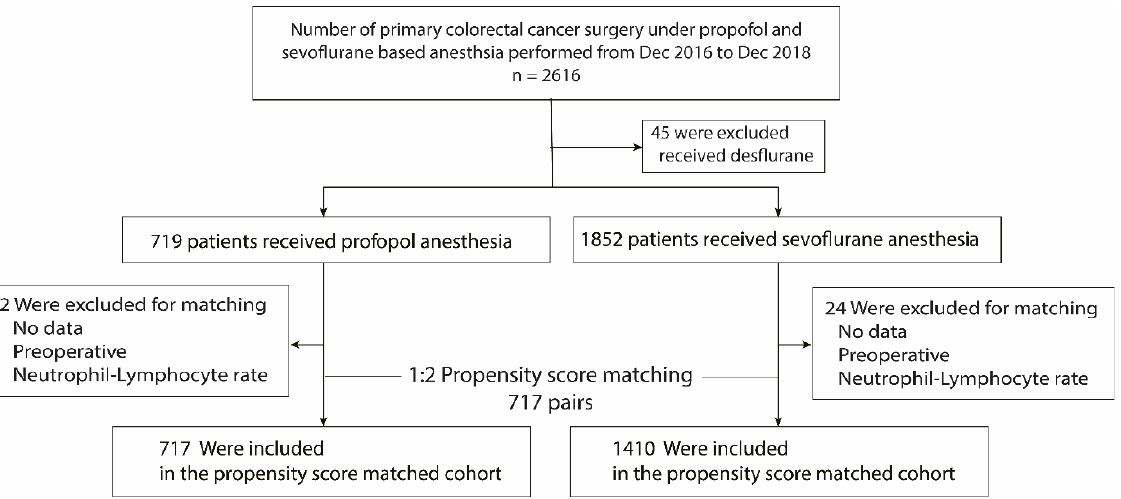
Figure 1. Flow diagram detailing the selection of patients included in the retrospective analysis.